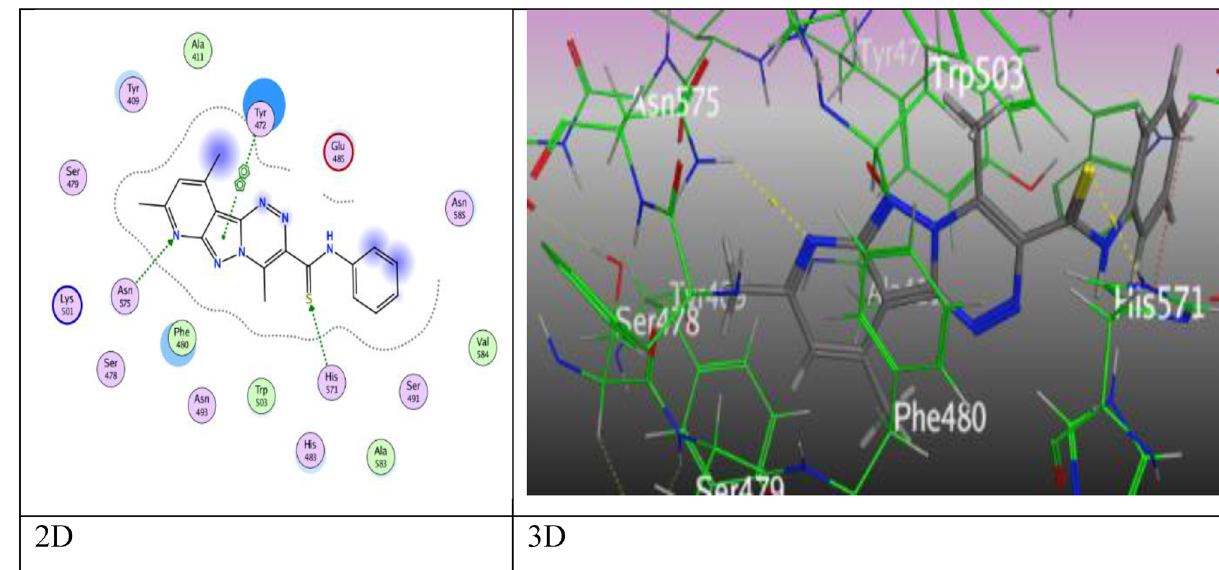
Figure 11. The binding interactions of compound 6a with active sites of (PDB ID: